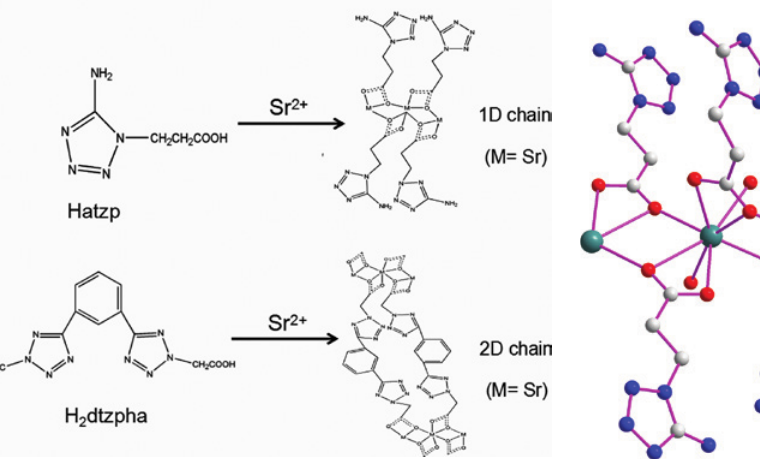
Scheme 1: The synthesis procedure caused by the differences in the number of carboxylic acid groups of the